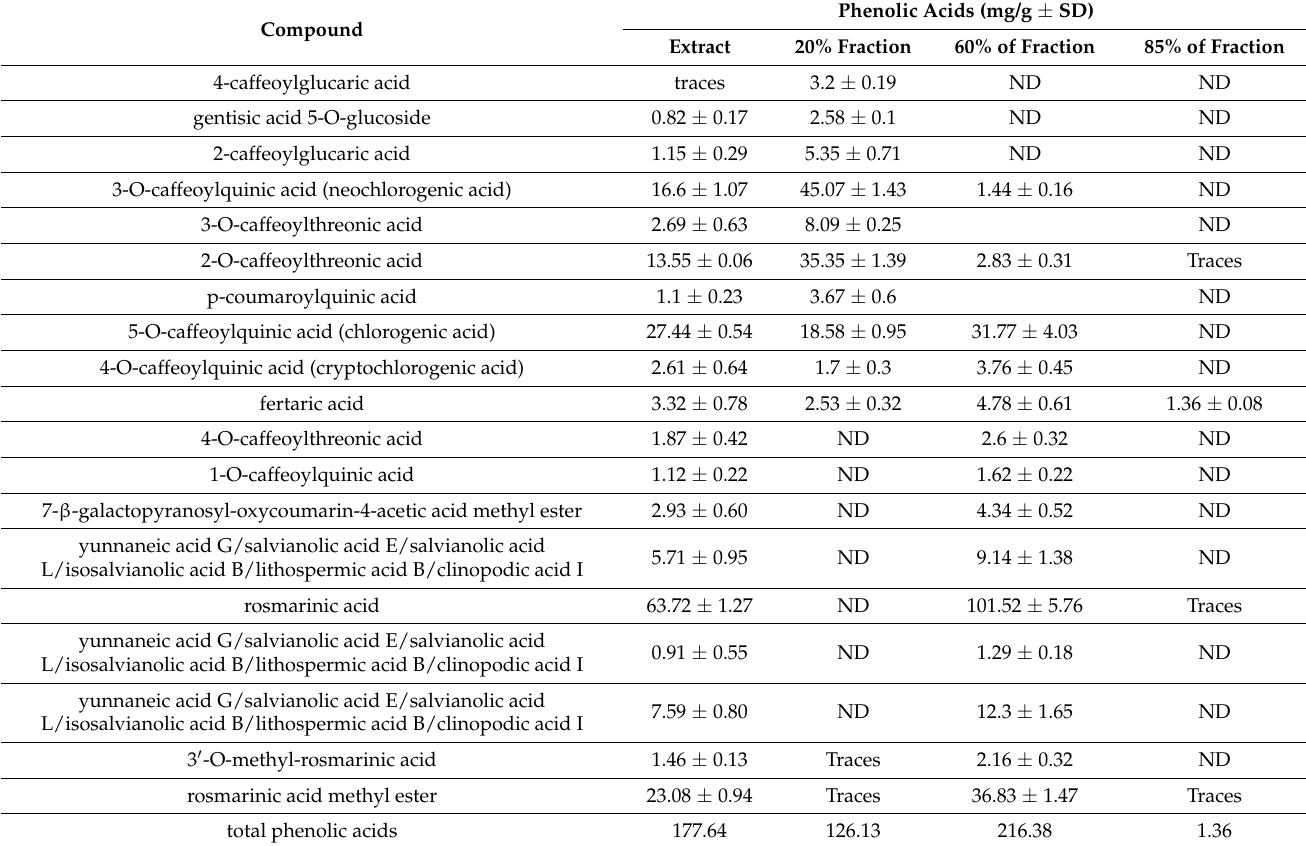
Table 2. Content of phenolic acids in the extract from G. hederacea and its fractions.